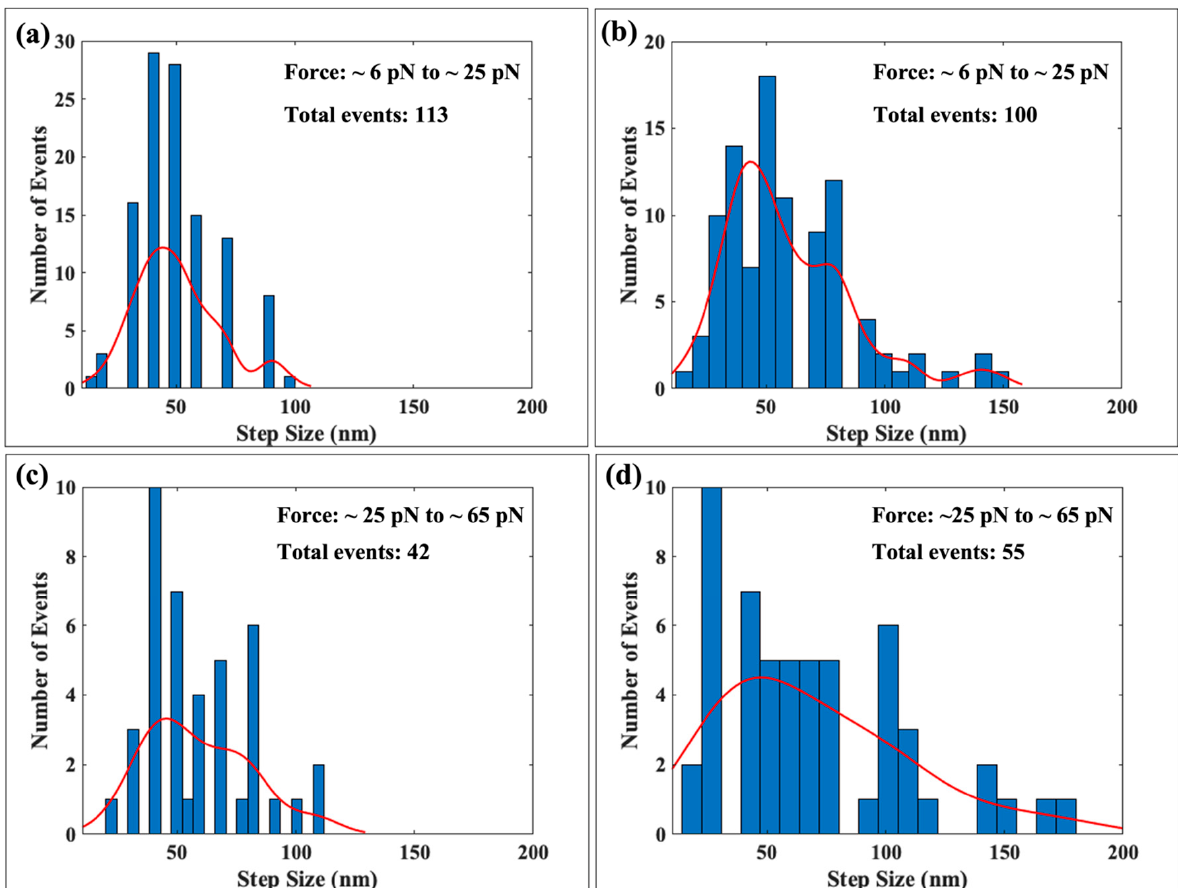
Figure 4. Step-size histograms comparing results obtained with native histones ( a , c ) to those obtained with hyperacetylated histones ( b , d ). ( a , b ) are for the moderate force range between 6 pN and 25 pN, while ( c , d ) for the high force range between 25 pN and 65 pN. The red curves are fits obtained using